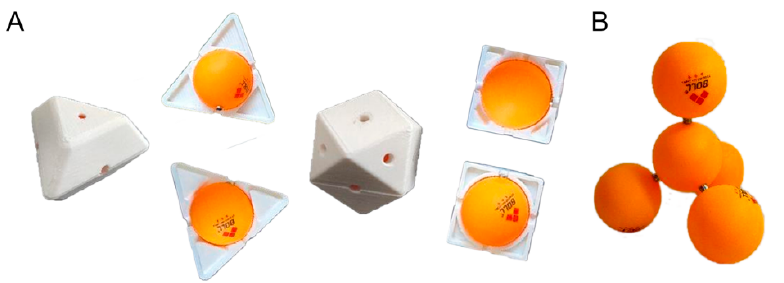
Figure 1. The molds and the structure of a tetrahedron. ( A ) The tetrahedral molds with locational holes for the magnets. ( B ) The ideal assembled tetrahedron structure is similar to the methane molecule.